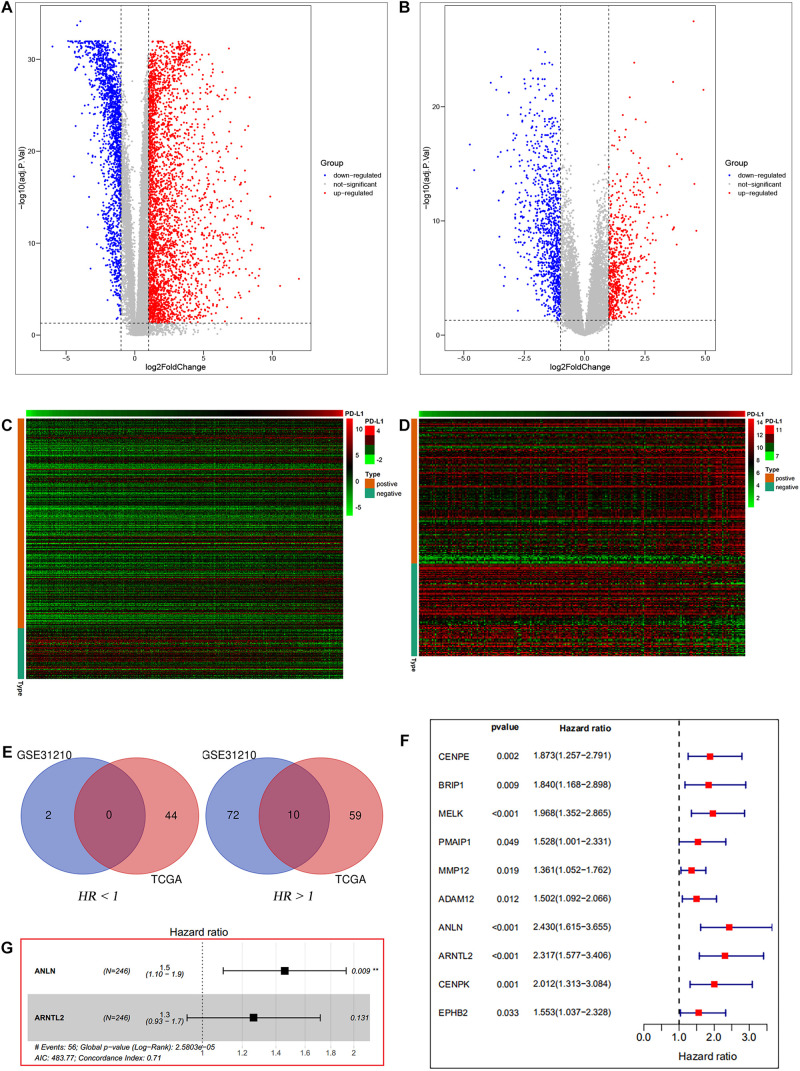
Data filters. Differential expression analysis between lung tumor and normal tissues based on TCGA database (A) and GSE31210 dataset (B). PD-L1 correlation analysis based on TCGA database (C) and GSE31210 dataset (D). The intersection of prognosis-related genes in the two datasets (E). Univariate Cox analysis of the intersection genes of the two datasets based on TCGA entire set (F). Multivariate Cox analysis of the intersection genes of the two datasets based on TCGA train set (G).